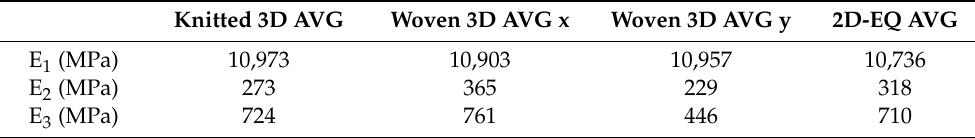
Figure 11. Tensile comparison of averaged curves of all layups. Table 4. Averaged stiffness in three stages in tension for all layups.